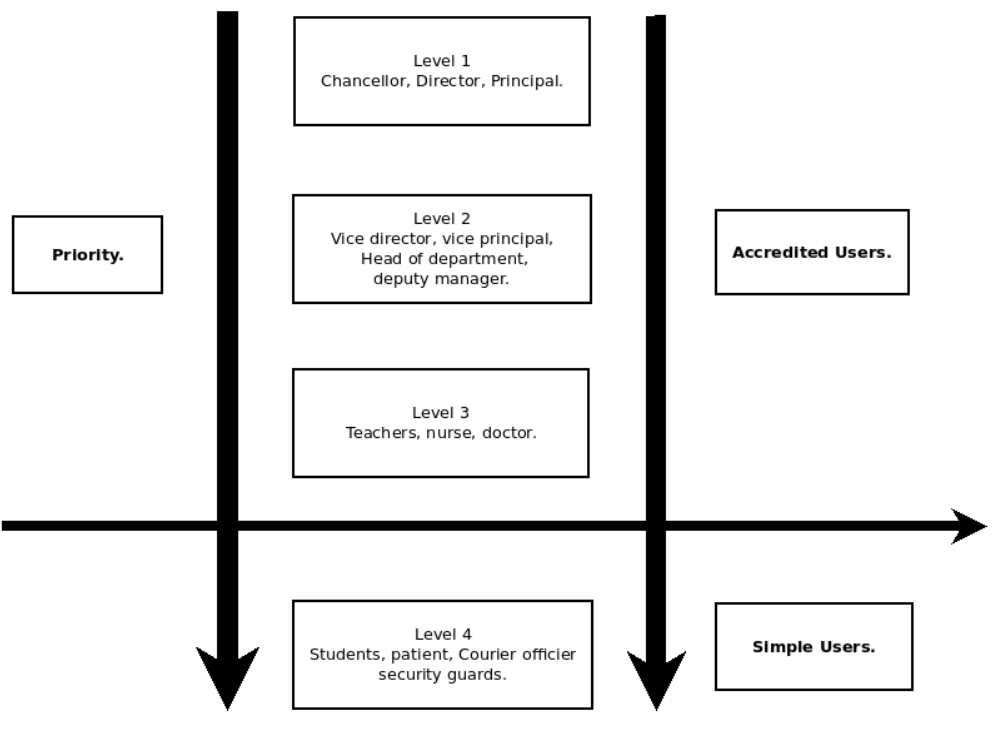
Figure 2. Level of user